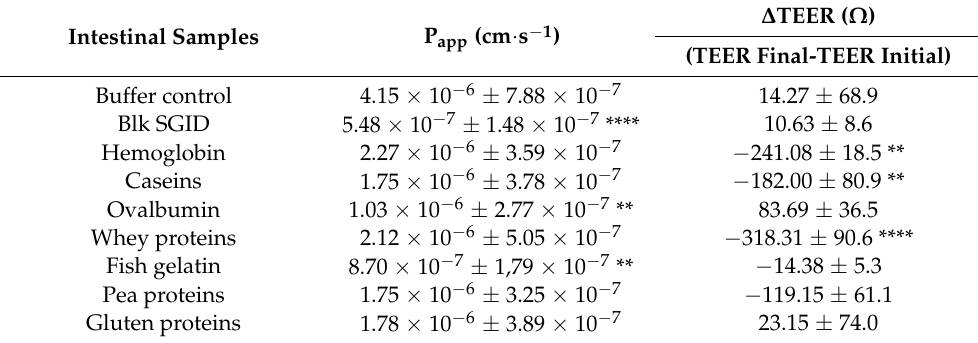
Table 2. Digested proteins modulate the permeability and IB integrity differently.